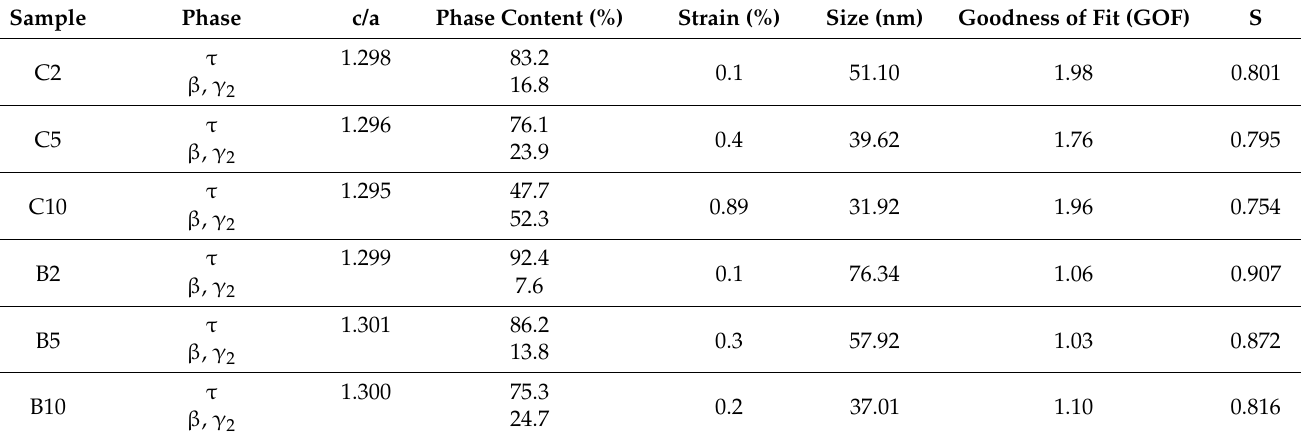
Figure 2. XRD patterns of Mn 52 Al 45 . 7 C 2 . 3 : ( a ) bulk, ( b ) prepared with a cylindrical container, and ( c ) prepared with a barrel container with different milling times. Table 2. Summary of the refined XRD parameters for the Mn 52 Al 45 . 7 C 2 . 3 samples after milling in cylindrical and barrel containers for 2, 5, and 10